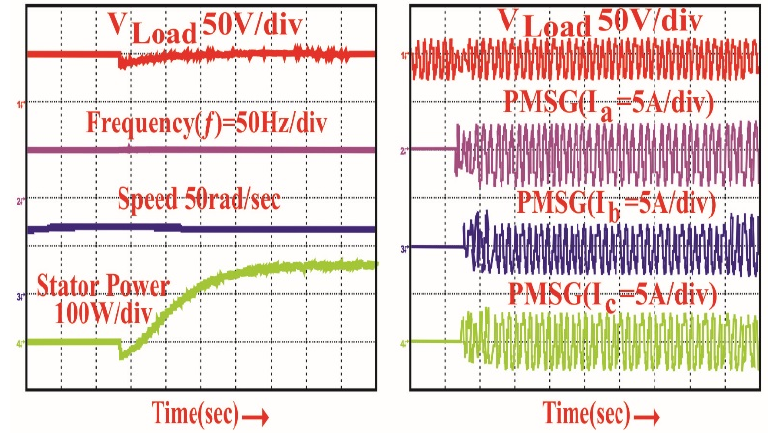
Figure 16. The performance of the wind generator is evaluated under reconnecting operating conditions